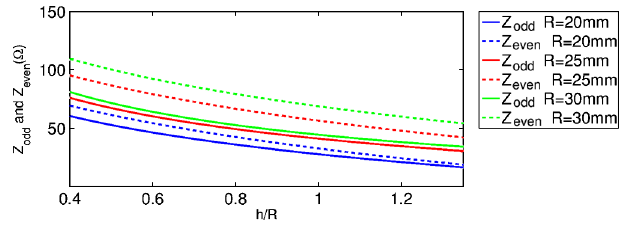
FIG. 6. Analytical estimate for the odd and even modes characteristic impedance versus h =